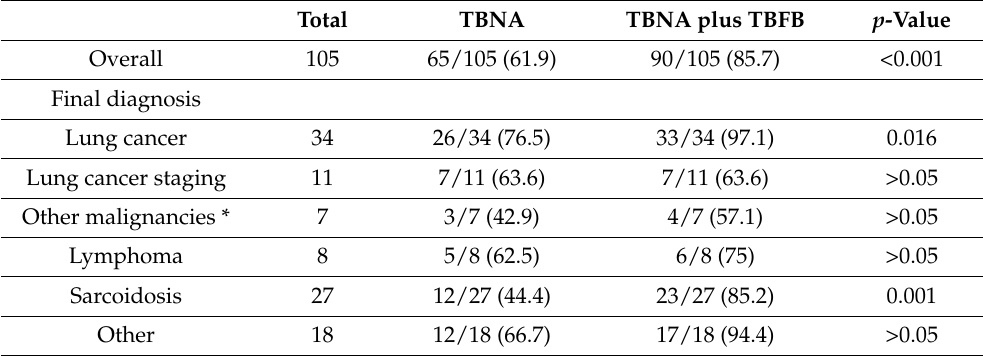
Table 4. Diagnostic yield of TBNA and TBNA plus TBFB overall and divided into the final